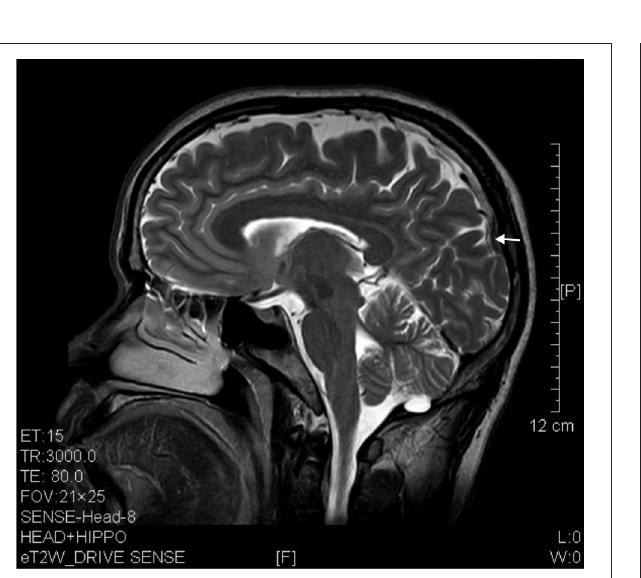
FIGURE 5 | T2 image showed prefrontal and occipital atrophy (arrows) in a sagittal brain section of a 7 years’ ketamine